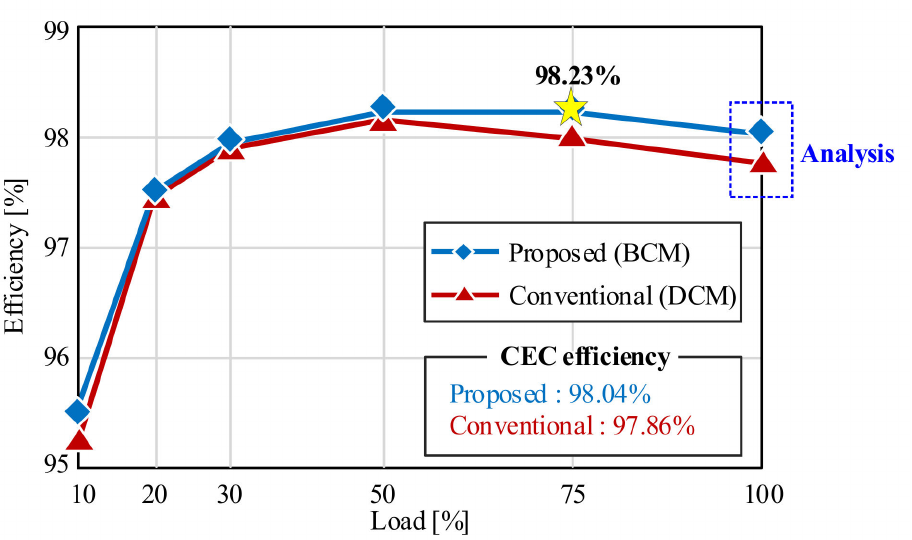
Figure 17. Measured efficiency comparison between the proposed PWM control scheme and the conventional PWM control scheme when V pv = 720 V and V o = 900 V.